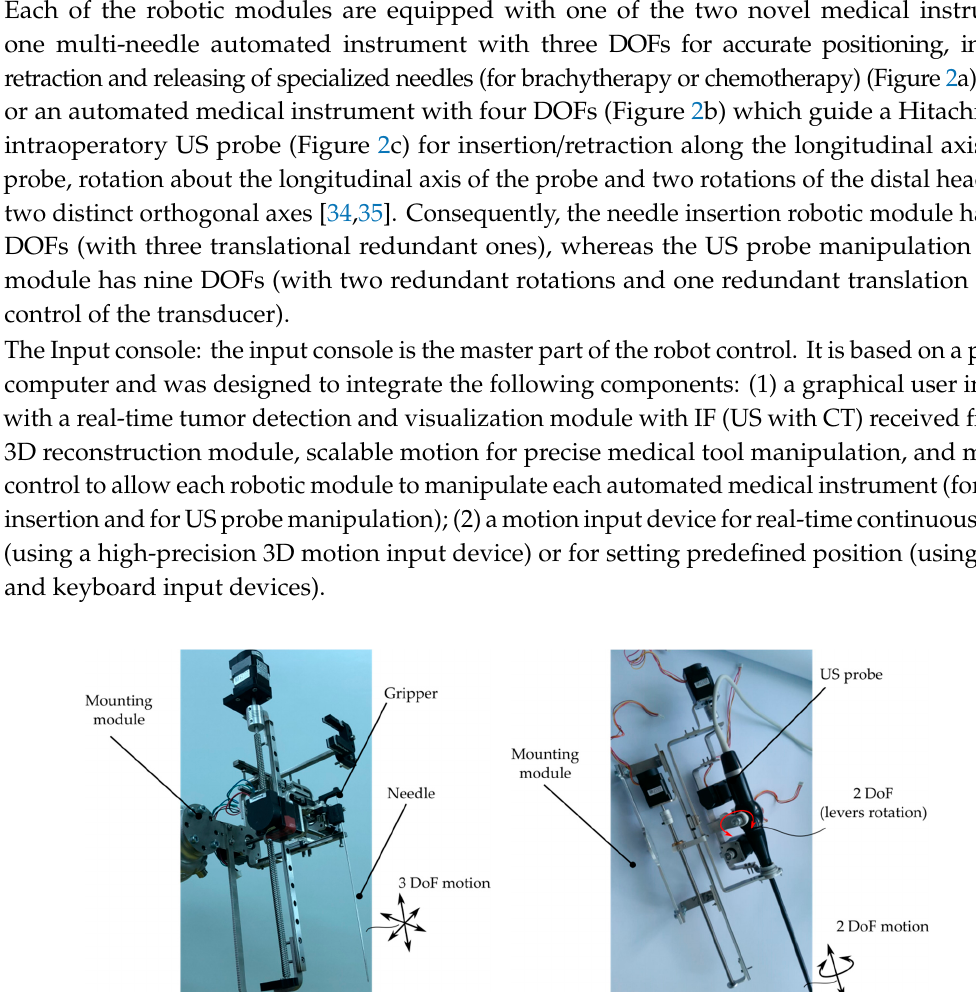
Figure 1. ProHep-LCT robotic system: ( a ) robotic system in “mirrored” configuration; ( b ) one module guiding of the robotic system.